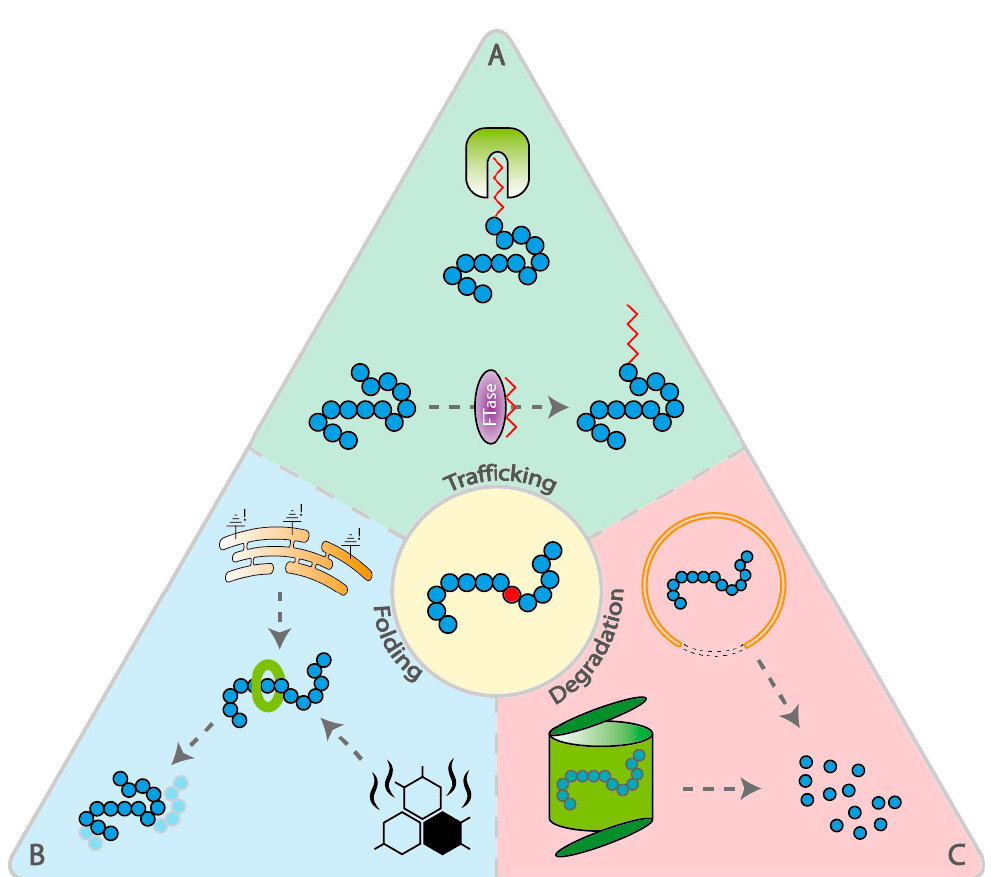
Figure 1. Schematic representation of the different branches of the proteostasis network, divided into trafficking, folding and degradation. (A) Trafficking: Protein prenylation involves the transfer of either a farnesyl or a geranylgeranyl moiety to the C-terminal cysteine(s) of the target protein by farnesyltransferase (FTase) and geranylgeranyltransferase (GGTase-I), respectively. Chaperones involved in regulation of this prenylation process and trafficking of prenylated proteins, include AIPL1, PDE6D, and UNC119 (depicted in green). (B) Folding: Two responses that are activated upon protein misfolding are the unfolded protein response (UPR) and the heat shock response (HSR). Both responses result in enhanced expression of chaperones (depicted in green) in order to restore the correct folding of proteins. (C) Degradation: ER-associated degradation (ERAD) results in the degradation of proteins by the ubiquitin–proteasome system (UPS). Another pathway of protein degradation is autophagy. Background colors in figure (green, blue, and red) correspond with background colors of Table 1.